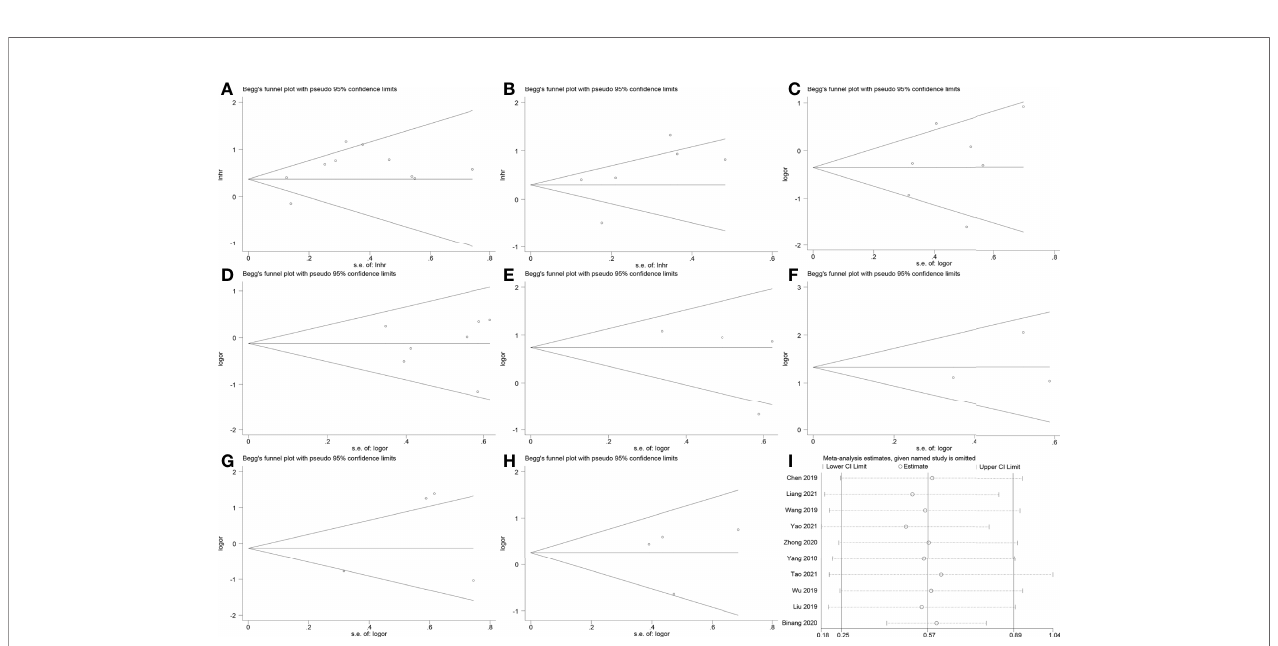
FIGURE 7 | Begg ’ s funnel plots and sensitivity analysis. (A) Begg ’ s funnel plot for OS. (B) Begg ’ s funnel plot for DFS. (C) Begg ’ s funnel plot for age. (D) Begg ’ s funnel plot for gender. (E) Begg ’ s funnel plot for lymph node metastasis. (F) Begg ’ s funnel plot for tumor size. (G) Begg ’ s funnel plot for tumor stage. (H) Begg ’ s funnel plot for distant metastasis. (I) Sensitivity analysis for studies about